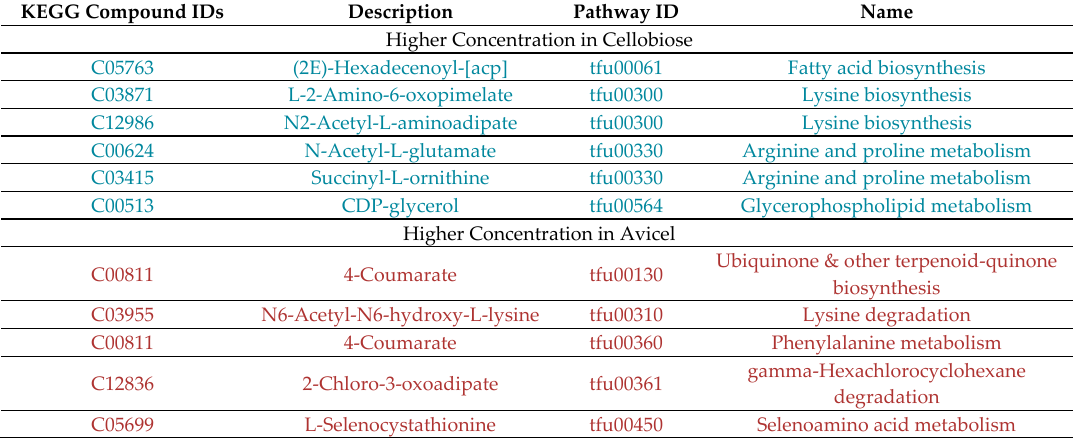
Table 4. Compounds with significantly different concentrations as detected in two growth media conditions (green—cellobiose, red—Avicel).